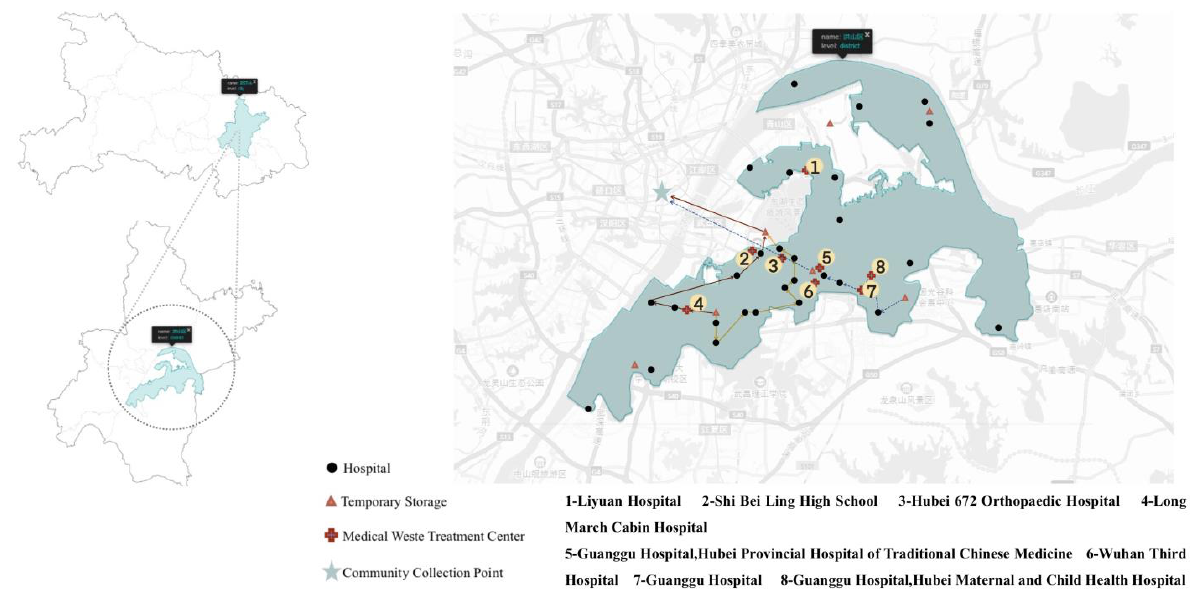
Figure 2. Distribution of health facilities, communities, temporary storage, community collection points. Table 1. Hospitals represented by serial numbers in Figure 2.